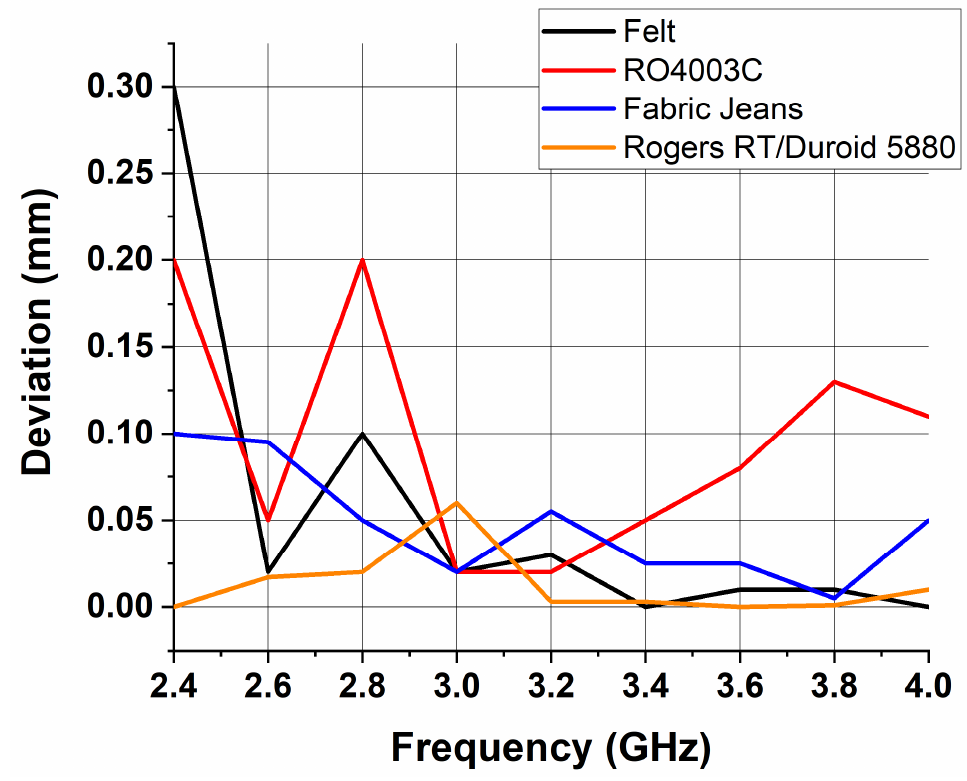
Figure 4. Deviation of results for different substrates.